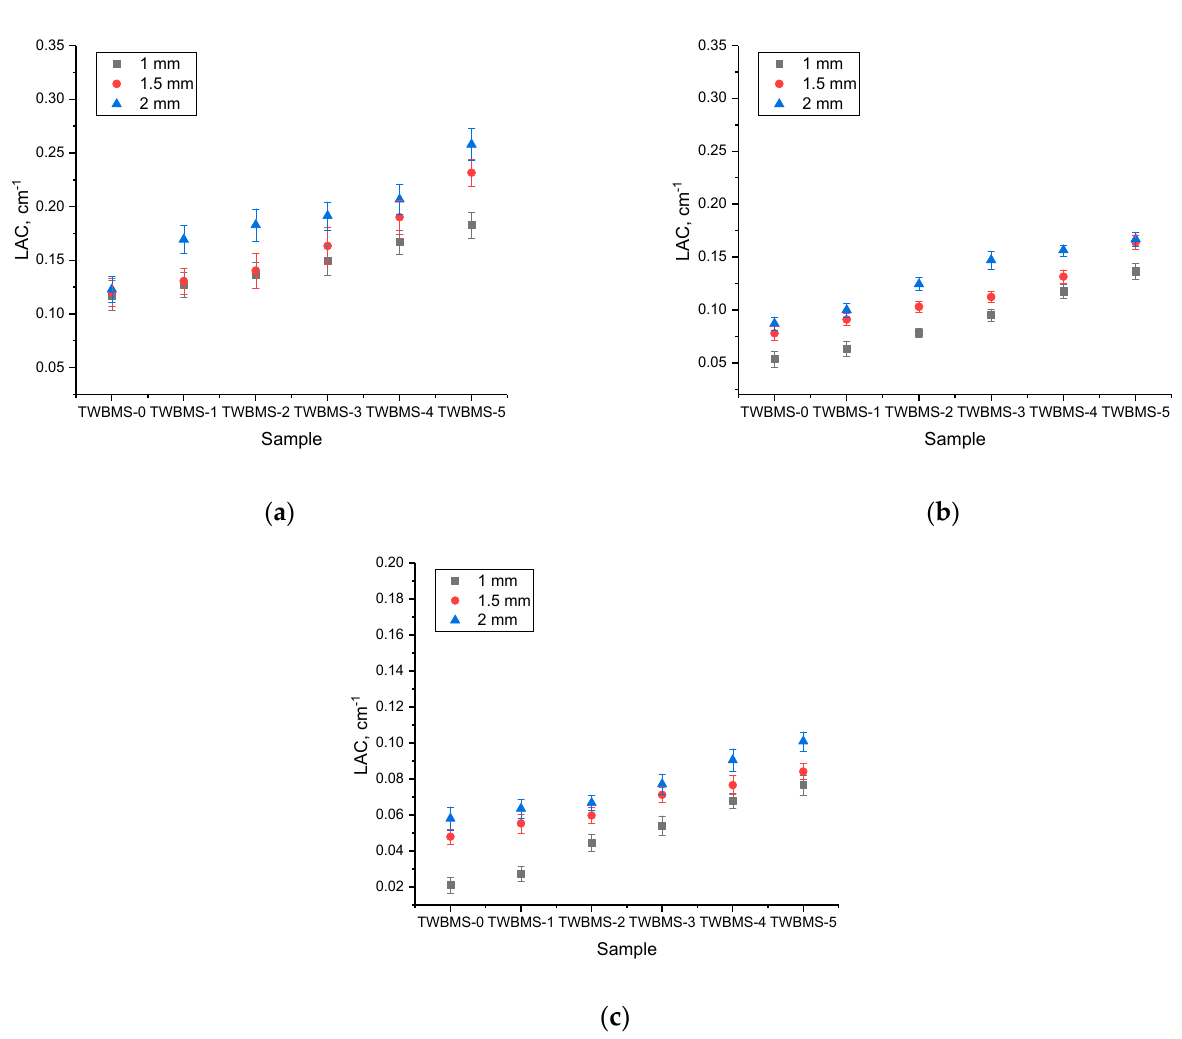
( c ) Figure 5. Results of evaluation of the change in the mass attenuation coefficient of gamma radiation depending on the type of gamma-quantum source: ( a ) Co 57 , 130 keV; ( b ) Cs 137 , 660 keV; ( c ) Na 22 , 1270 keV.